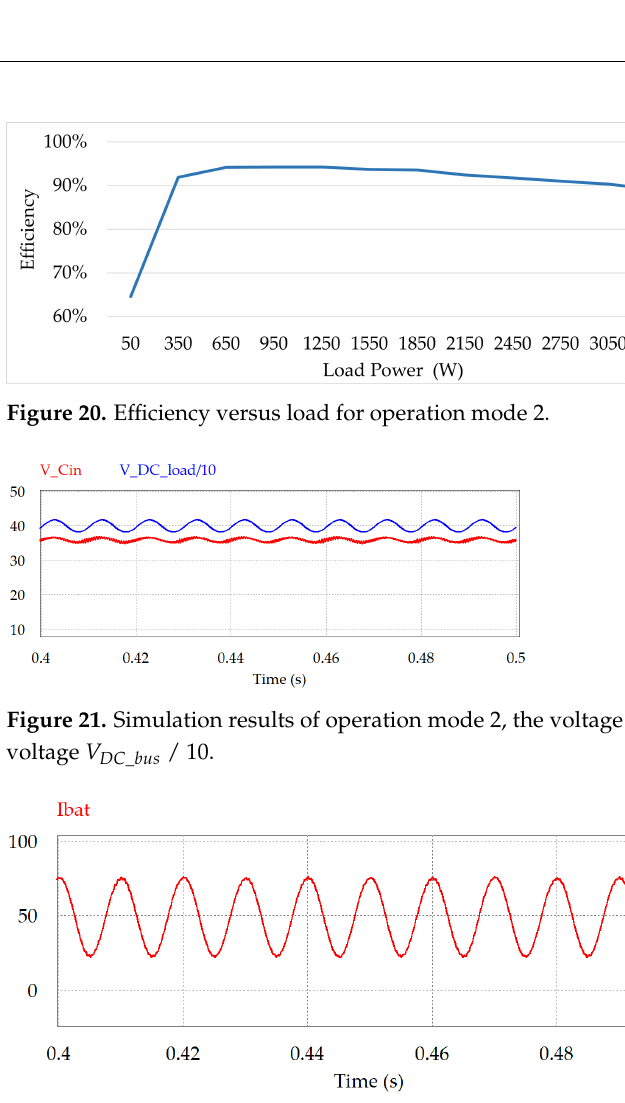
Figure 22. Simulation results of operation mode 2, battery discharging current I bat